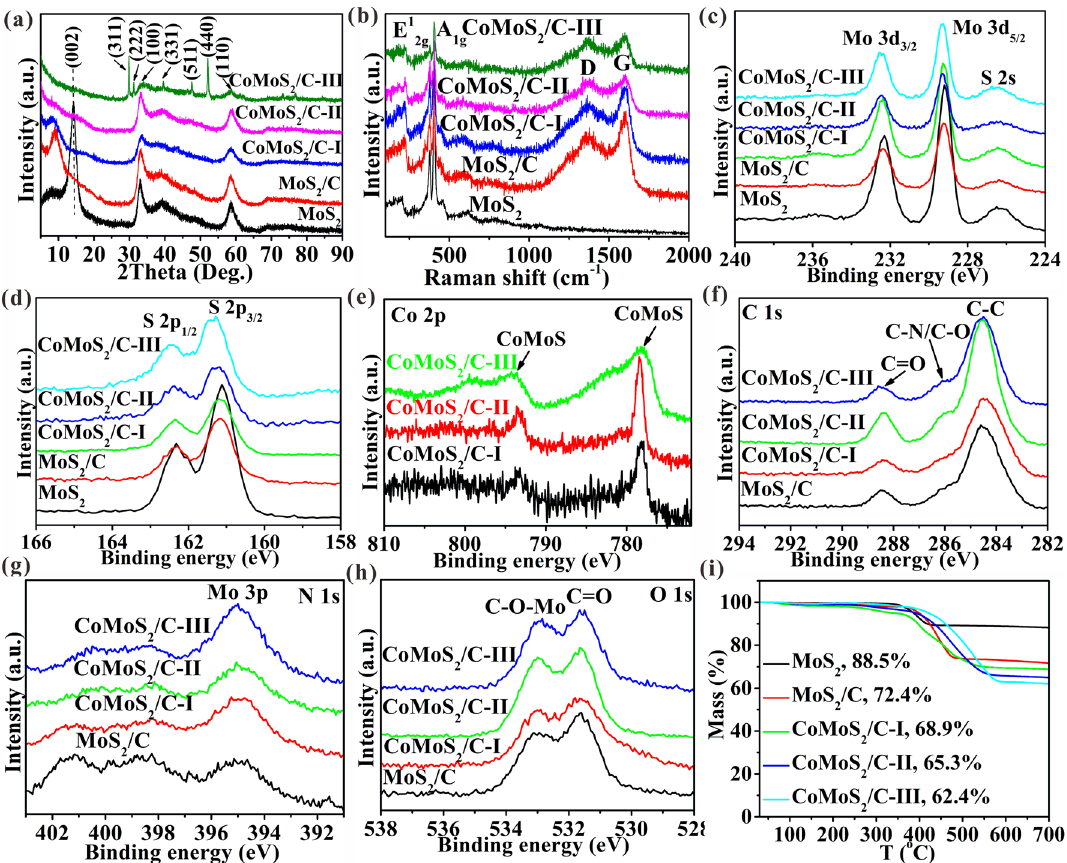
Fig. 2 Sample analysis. a XRD, b Raman, XPS spectra of c Mo 3 d , d S 2 p , e Co 2 p , f C 1 s , g N 1 s , h O 1 s , and i